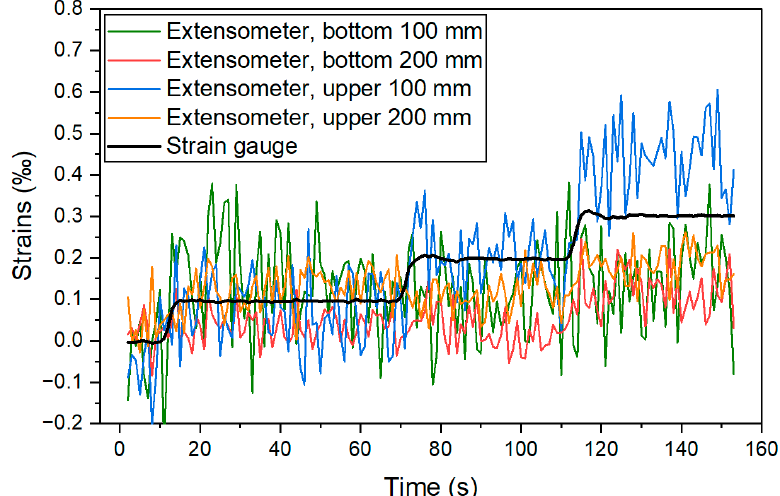
Figure 22. Comparison of the strain measurements in the elastic range in the α‐α section. Then, the results obtained in the test when the beam was damaged were